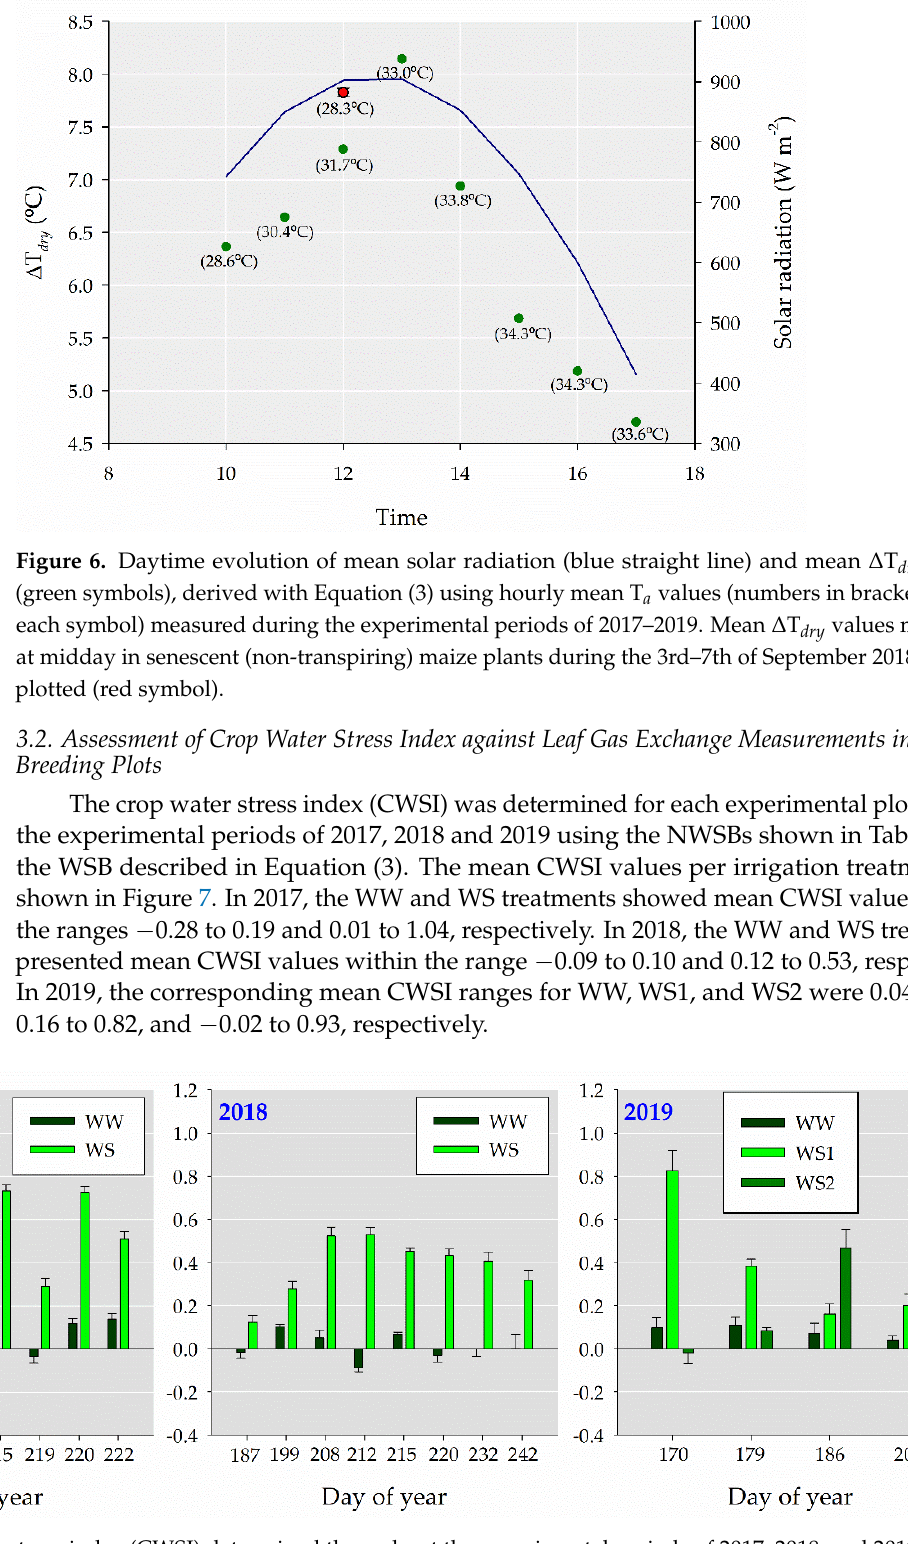
Figure 8. Mean ∆ T values observed during the water stress period in the deficit irrigation treatments (WS). In 2019, the first two dates correspond to the flowering stress treatment (WS1) and the last two dates to the grain-filling stress treat- ment (WS2). For each measurement date, the ∆ T dry values calculated with Equation (3) are also plotted. Each bar indicates the mean ± s.e. of 18 (2017, 2018) and 12 (2019) maize breeding plots. Stomatal conductance (g s ) and leaf photosynthesis rate (A) averaged per irrigation treatment and date of measurement are shown in Figure 9. In 2017, the WW and WS treat- ments showed mean g s values within the ranges 150 to 350 mmol m − 2 s − 1 and 4 to 39 mmol m − 2 s − 1 , respectively. In 2018, the WW and WS treatments presented mean g s values within the ranges 200 to 370 mmol m − 2 s − 1 and 50 to 210 mmol m − 2 s − 1 , respectively. In 2019, the corresponding mean g s ranges for WW, WS1, and WS2 were 382 to 396 mmol m − 2 s − 1 , 92 to 439 mmol m − 2 s − 1 , and 8 to 326 mmol m − 2 s − 1 , respectively. Regarding A, the WW and WS treatments showed mean A values in 2017 within the ranges 28 to 46 μ mol m − 2 s − 1 and 0.3 to 8.8 μ mol m − 2 s − 1 , respectively. In 2018, the corresponding mean A values for WW and WS treatments varied within the ranges 11 to 30 μ mol m − 2 s − 1 and 11 to 23 μ mol m − 2 s − 1 , respectively. In 2019, the WW, WS1, and WS2 treatments showed mean A values within the ranges 33 to 55 μ mol m − 2 s − 1 , 19 to 61 μ mol m − 2 s − 1 , and 4 to 44 μ mol m − 2 s − 1 , respectively.